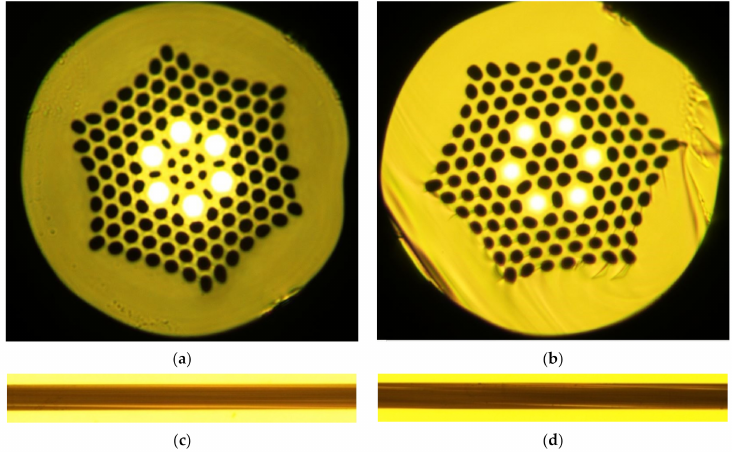
Figure 9. Twisted six-core-MOFs with graded-index cores as supporting elements: ( a ) cross-sectional view of the fabricated MOF with a twisting of 50 rpm; ( b ) cross-sectional view of the fabricated MOF with a twisting of 100 rpm; ( c ) longitudinal view of the fabricated MOF with a twisting of 50 rpm; ( d ) longitudinal view of the fabricated MOF with a twisting of 100 rpm.